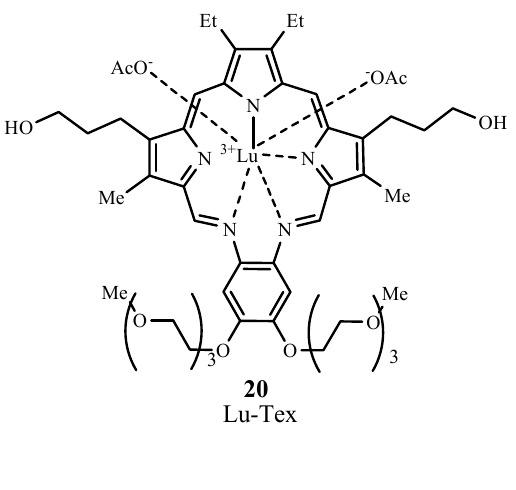
Figure 14. Molecular structure of a texaphyrin sensitizer.